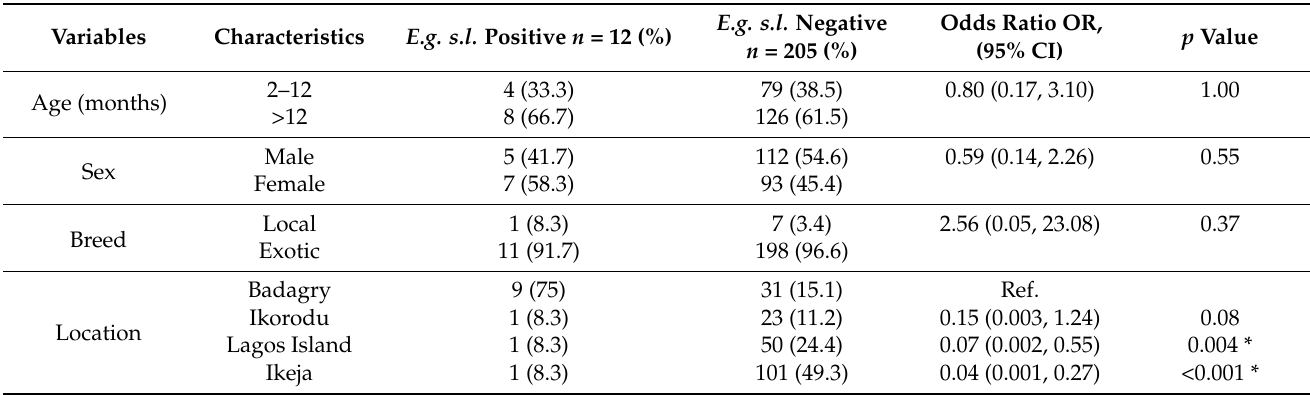
Table 3. Intrinsic and extrinsic factors associated with Echinococcus granulosus s.l. ( E.g. s.l. ) infection among owned dogs ( n = 217) presented at veterinary clinics or hospitals in Lagos State, Southwest Nigeria, in 2018–2019. Variables Characteristics